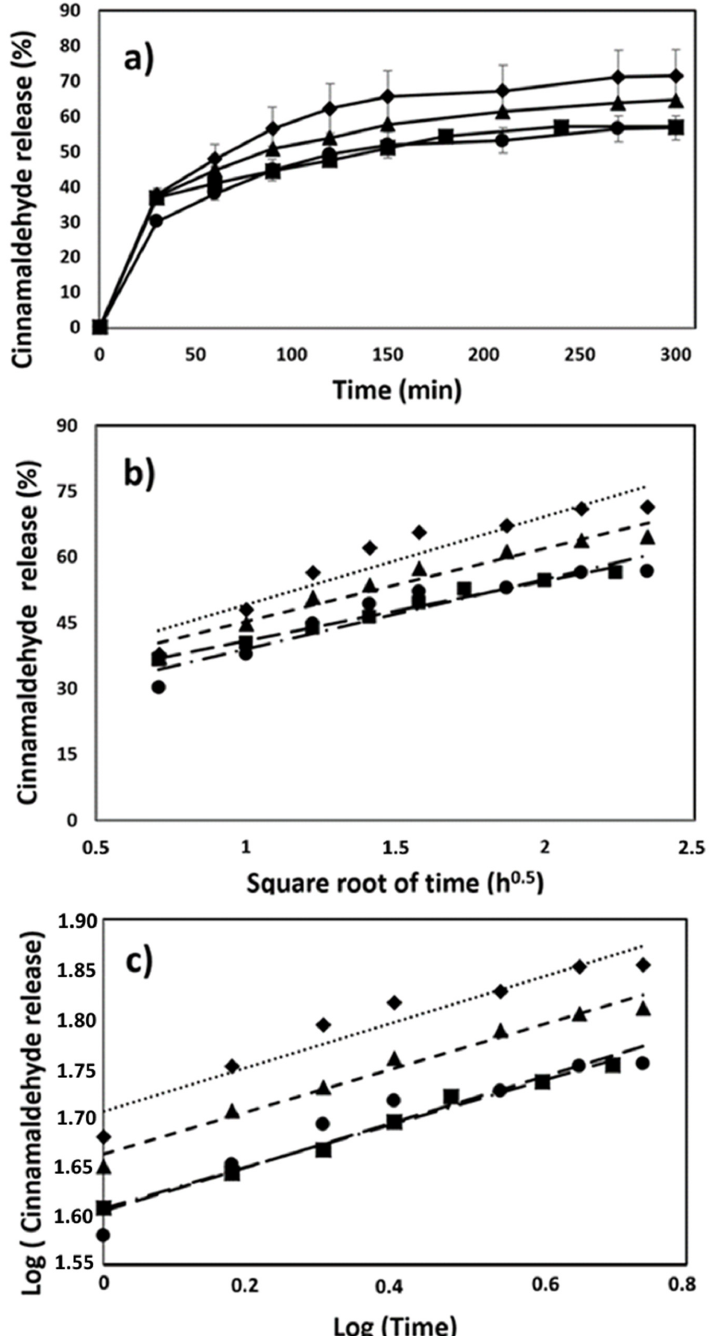
Figure 4. ( a ) Cinnamaldehyde release profiles in 50% EtOH at 40 °C and correlation of the cinnamaldehyde release process (dashed lines) from the PLA foams using ( b ) Higuchi and ( c ) Korsmeyer–Peppas kinetic models. Figures represent the experimental cinnamaldehyde release values from the following: = PLAf.Ci; = PLAf.1C30B.Ci; = PLAf.2C30B.Ci; and = PLAf.3C30B.Ci.